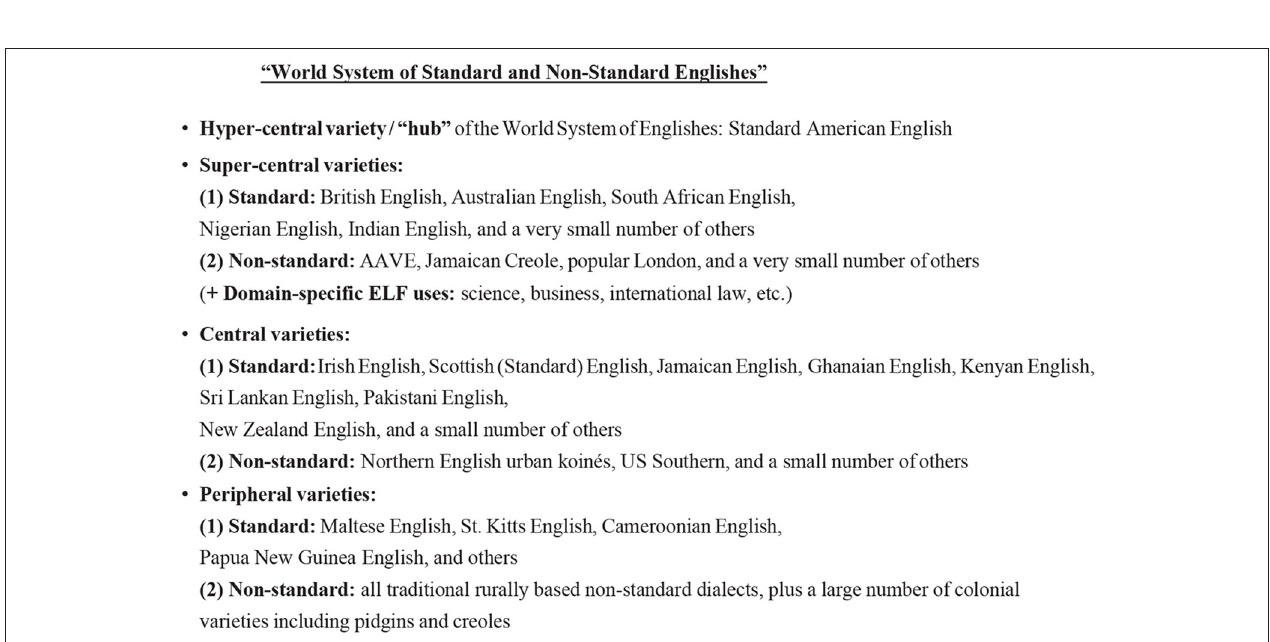
FIGURE 6 | Mair’s “World System of Standard and Non-Standard Englishes” (from Mair, 2013, p.